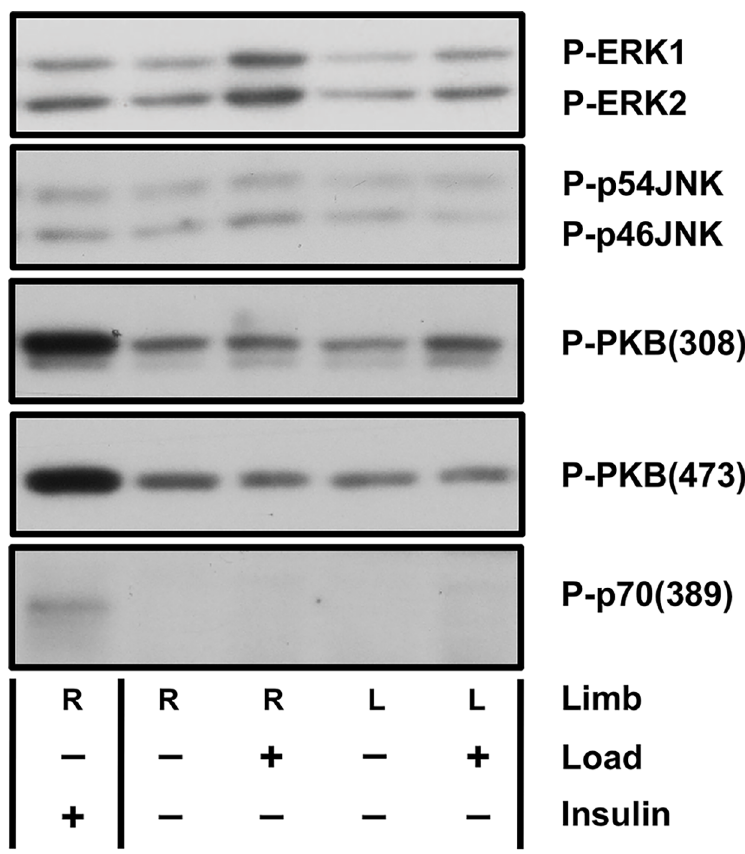
Fig 2. Representative Western blots for bone signaling at 15 minutes after loading. Insulin treatment served as positive control. Paired right and left limbs from Sham and Loaded rats were compared (n = 3/group). Phosphorylation of ERK and JNK were significantly increased in the loaded right ulnae at 15 minutes after loading compared to sham and contralateral limbs. The upper band was quantified for P-p54JNK.